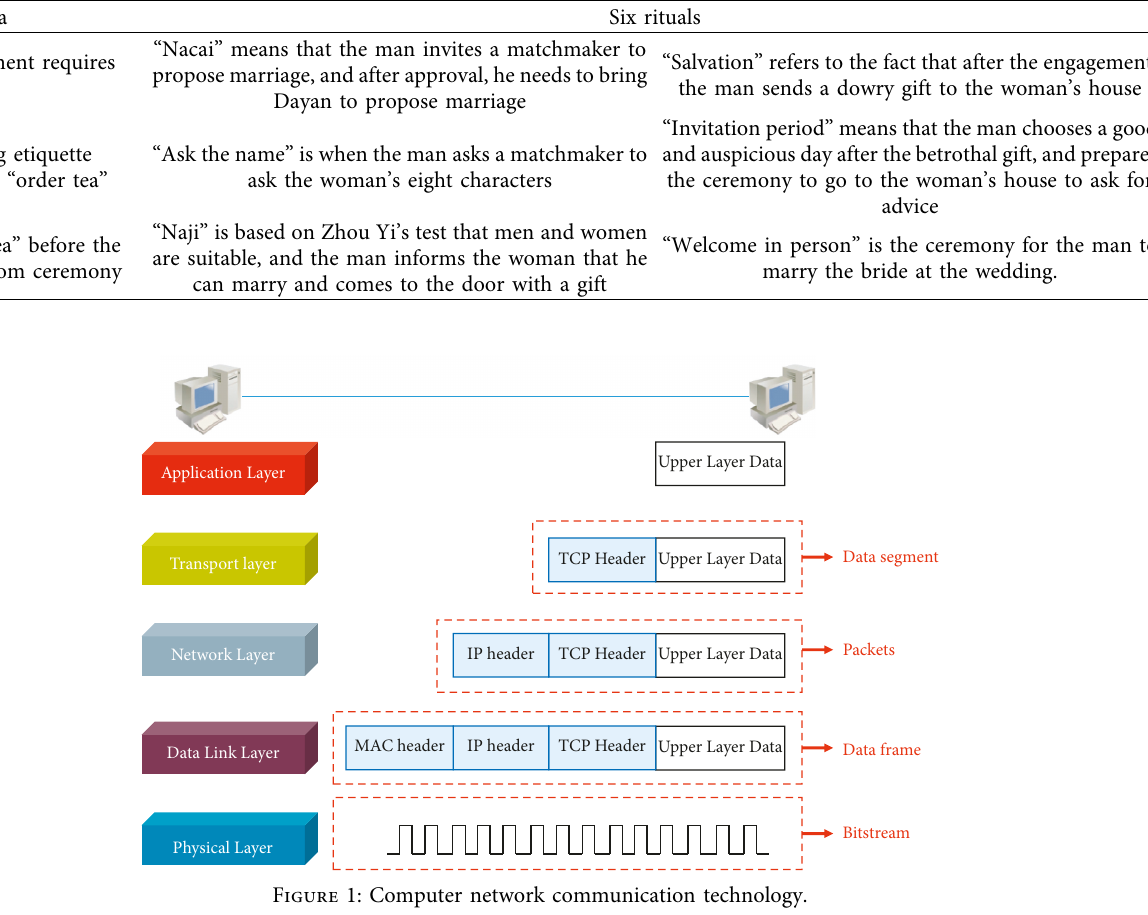
Table 1: Characteristic tea culture and Chinese etiquette.